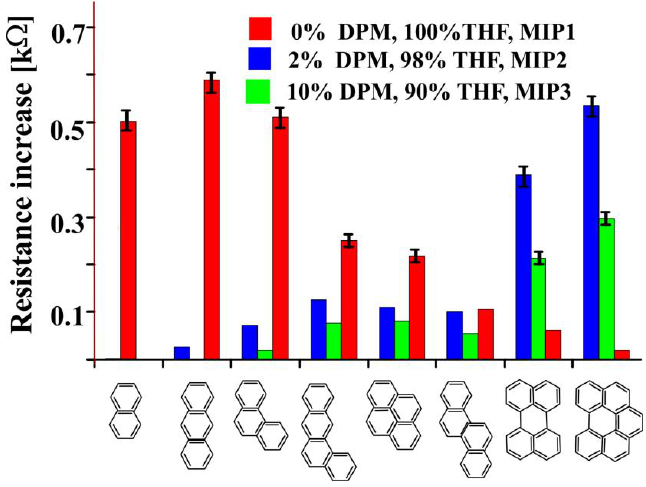
Figure 5. The effect of porogens on sensor responses of 5% anthracene imprinted polyurethane layer towards different PAHs.